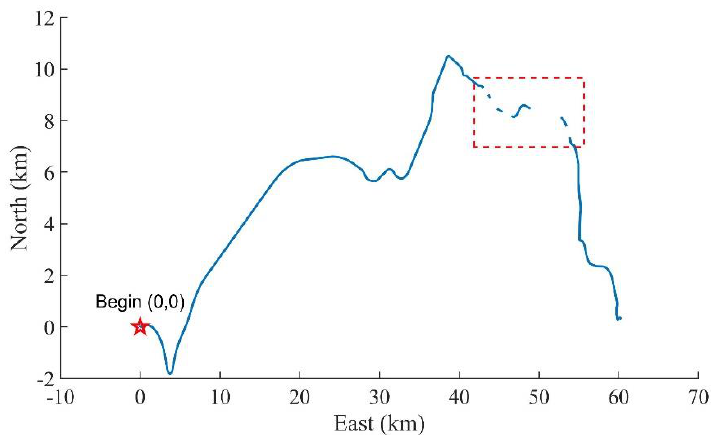
Figure 20. The trajectories of Experiment 2.